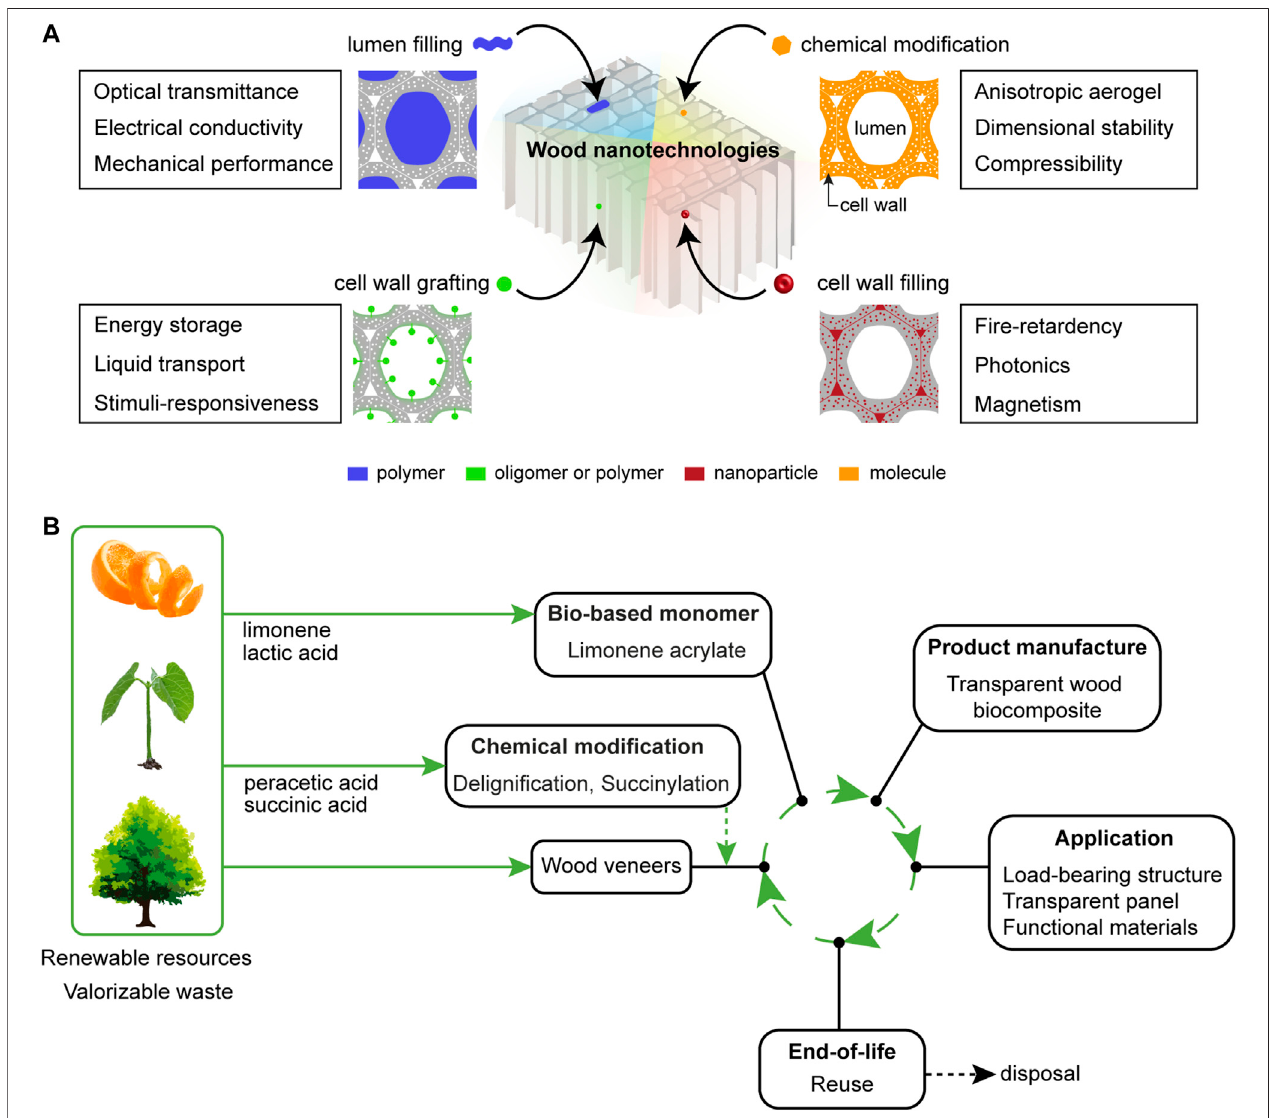
FIGURE 3 | (A) Chemical modi fi cation strategies for wood substrate functionalization. (B) Life cycle of fully bio-based transparent wood biocomposites. The bio- based transparent wood was prepared via green deligni fi cation treatment (peracetic acid) followed by solvent-free succinylation (succinic anhydride derived from